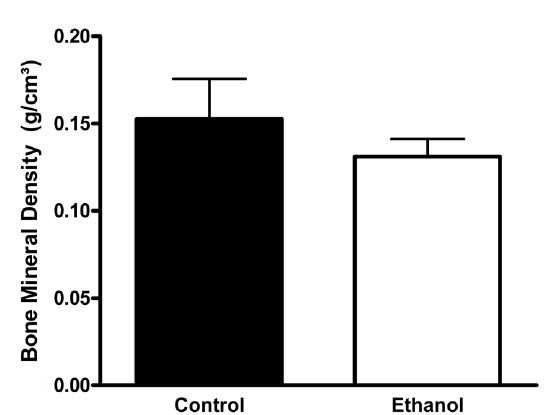
Figure 1. Comparison of bone mineral density (g/cm 3 ) between the control group (CG) and the ethanol group (GE). Mann-Whitney test;